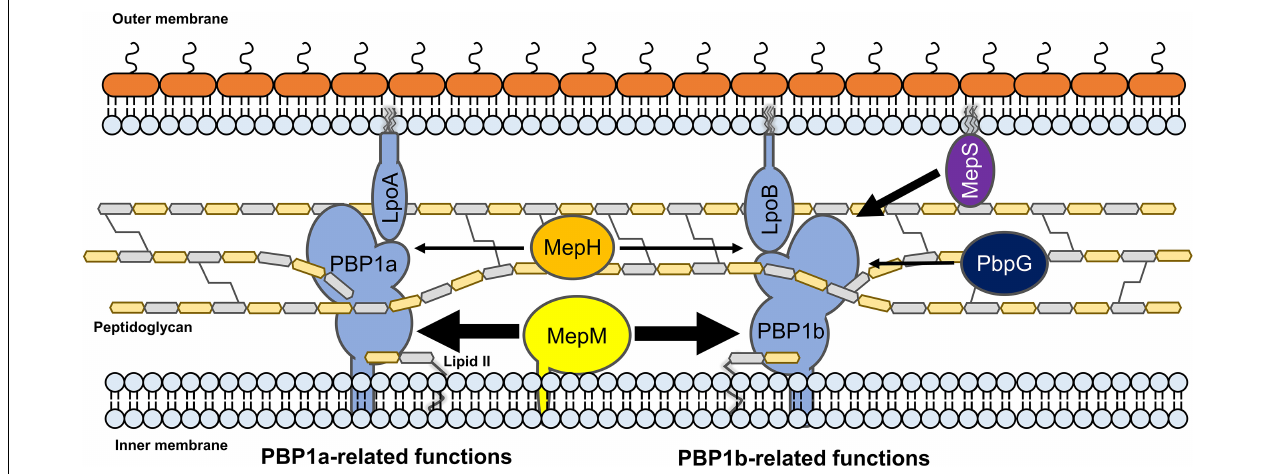
FIGURE 7 | The model for the distinct roles of MepM, MepS, MepH, and PbpG. MepM and MepS are located in the inner membrane and outer membrane, respectively, whereas MepH and PbpG are located in the periplasm. MepM is a transmembrane protein, whereas MepS is a lipoprotein. MepM is genetically associated with both PBP1a and PBP1b, and MepH supports its function. MepS is genetically associated with PBP1b, and PbpG supports its function. The width of arrows indicates the degree of the effects of endopeptidases on PBP1a or PBP1b.